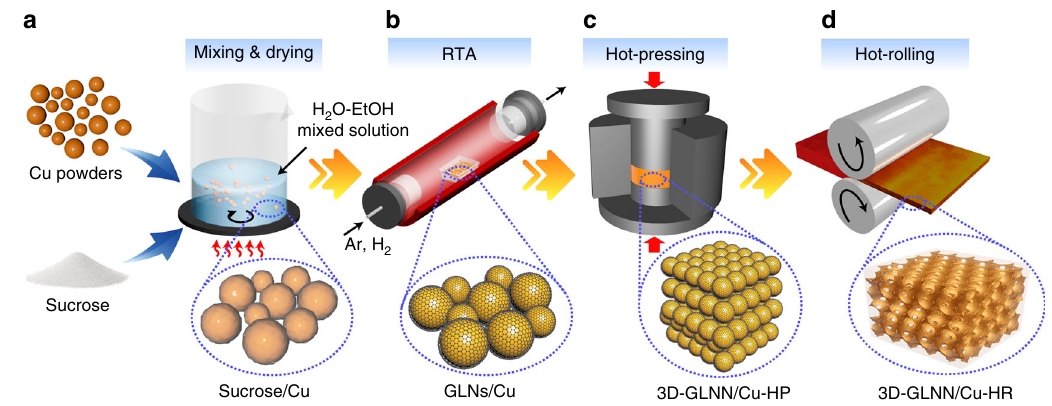
Fig. 1 Schematic illustration of overall fabrication processes. a The Cu powders were fi rst coated with sucrose as a hybrid precursor. b The hybrid precursor was then subjected to RTA process for growing GLNs. c The GLNs were interconnected into a continuous network structure in the Cu matrix by using hot-pressing. d The fully-densi fi ed 3D-GLNN/Cu bulk composites were fabricated